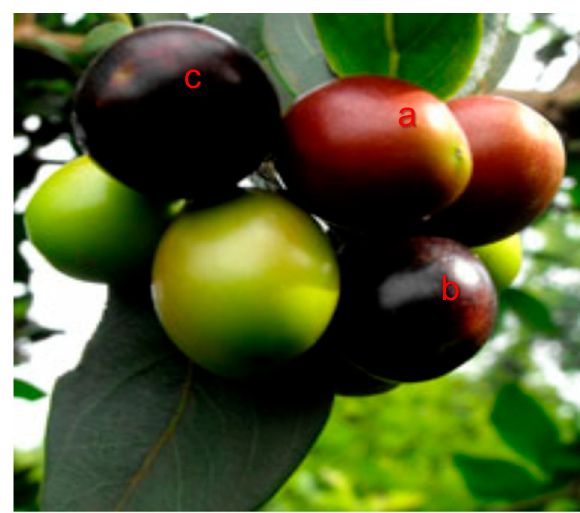
Figure 1. Carissa edulis fruits at different ripening stages used for the study. ( a ) First stage of ripening; ( b ) second stage of ripening and ( c ) last stage of ripening. Source: Makumbele [4].